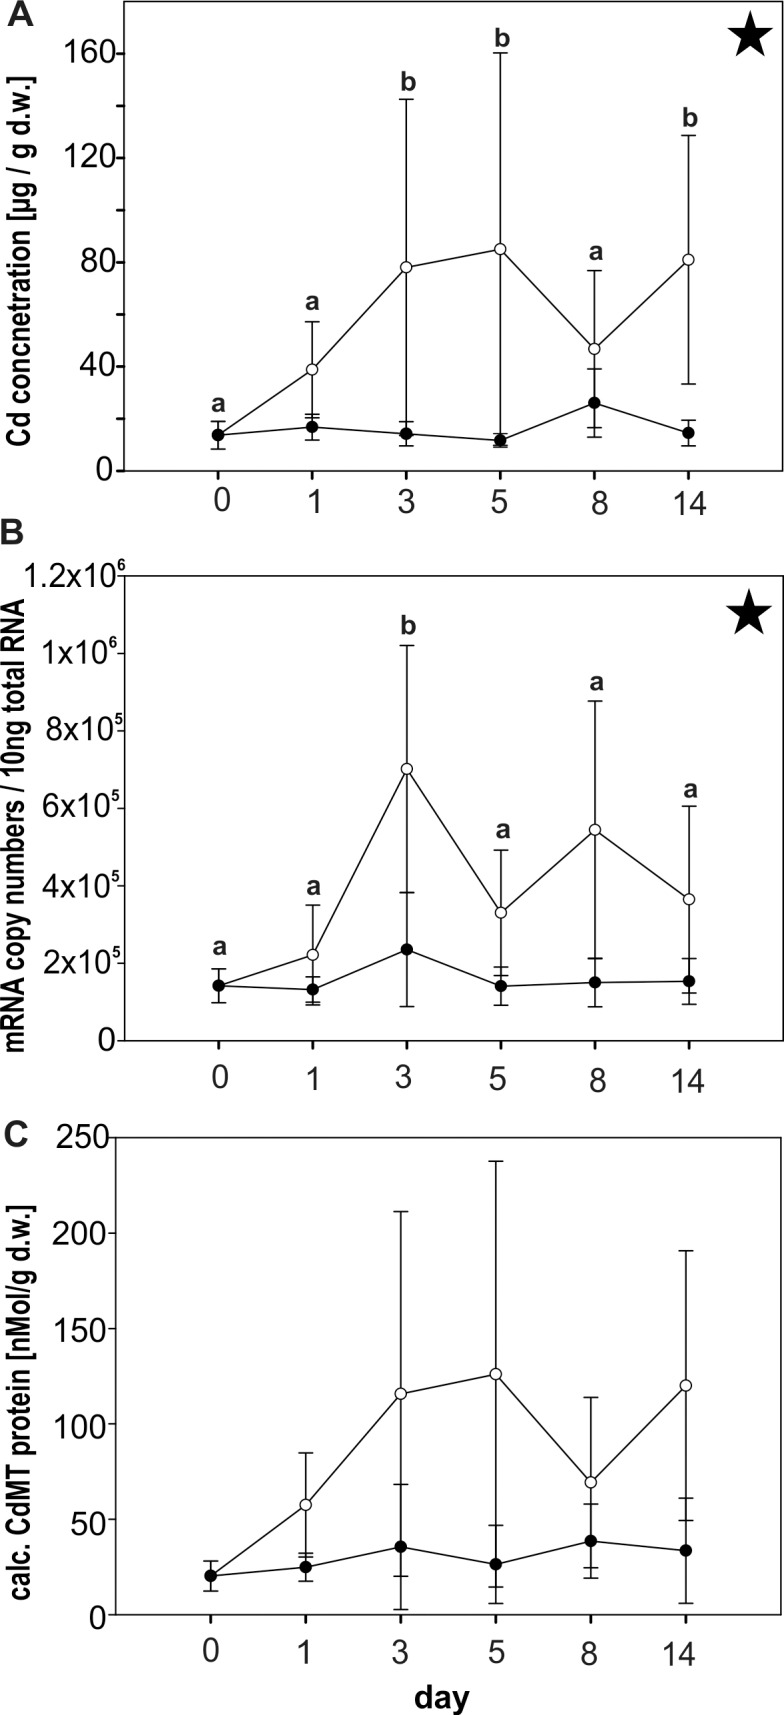
Cd accumulation and upregulation of the CdMT gene in Helix pomatia due to Cd stress.Cd concentrations (d.w.) (A), CdMT mRNA copy numbers (B) and calculated CdMT protein concentrations (C) of control Roman snails (black circles) and Cd-exposed individuals (white circles) were assessed over a period of 14 days. For both groups (n = 4–5) mean values and standard deviations are shown. Significant differences through experimental time and treatment by Two Way ANOVA were detected for CdMT mRNA copy numbers (time—P = 0.007; treatment—P = <0.001) and Cd midgut gland tissue concentrations (P = 0.042) for Cd-exposed snails (asterisks). Significant differences between single day values by multiple comparisons are indicated by different lower case letters (a,b).